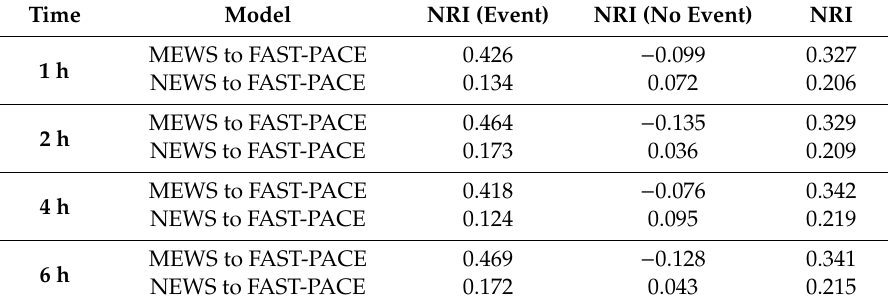
Figure 5. AUROC of FAST-PACE, MEWS, and NEWS predicting ( a ) acute respiratory failure and ( b ) cardiac arrest within 6 h. Table 6. Net reclassification index (NRI) in predicting acute respiratory failure.